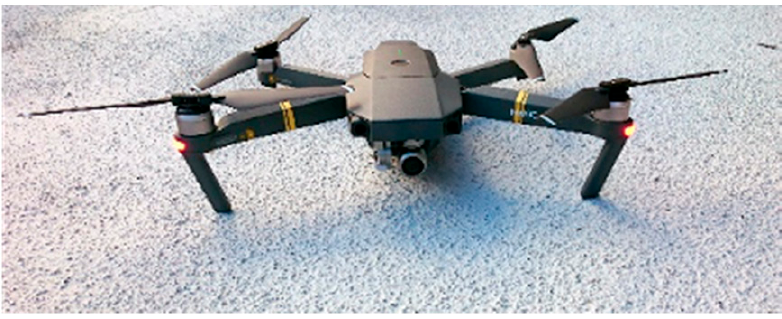
Figure 2. Workflow of the proposed approach in this research.